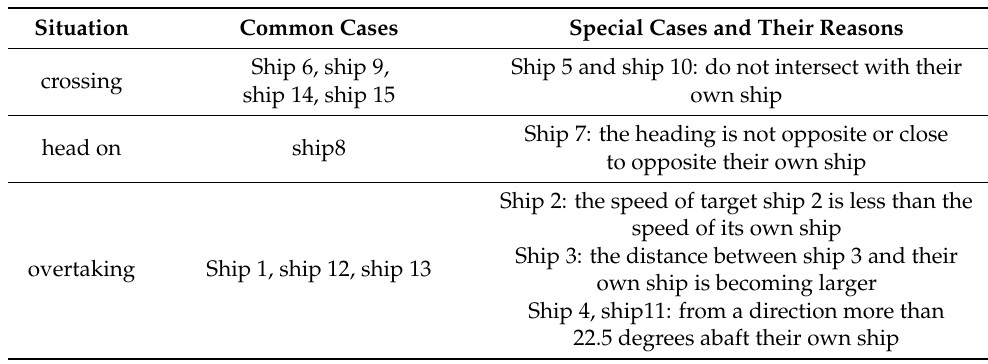
Figure 7. Types of ship encounter situations. Table 3. Three types of ship encounter situation and their special cases. Table 3. Three types of ship encounter situation and their special